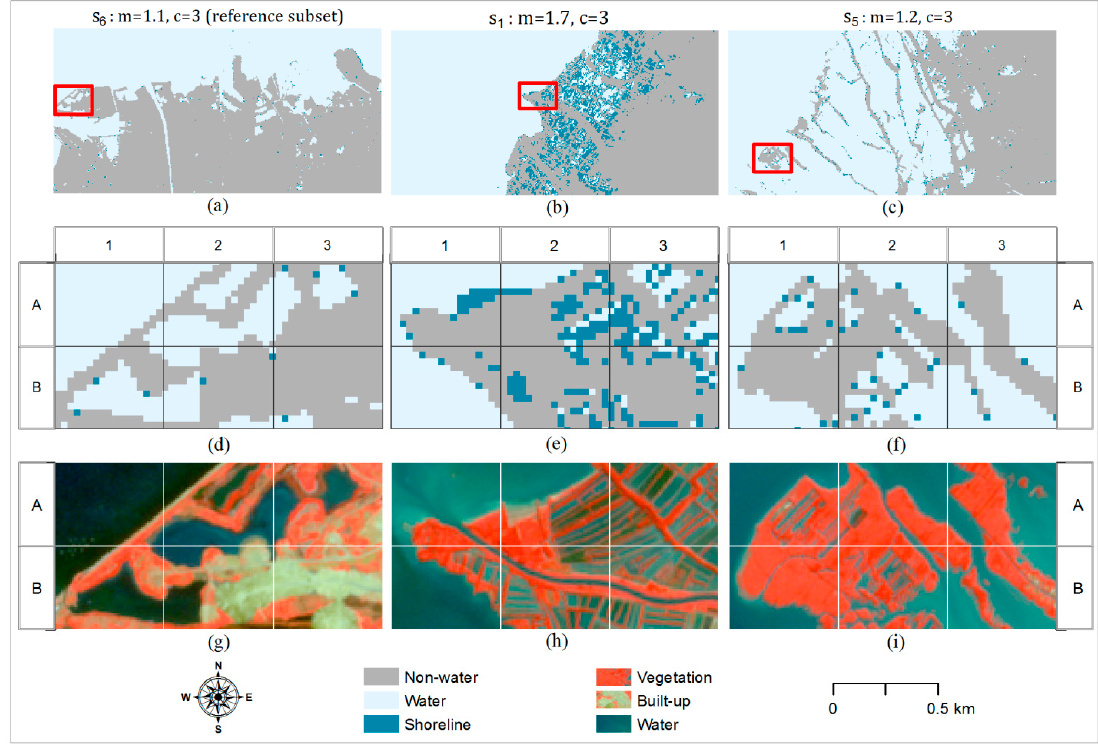
Figure 12. Subset s 6 ( a ) is the reference subset to estimate the FCM parameter for subsets s 1 and s 5 ( b , c ). We zoom into the red rectangle sites to see a more detailed representation of the area ( d – f ). The 2017 Sentinel-2 images show the different types of land use/cover ( g – i ). The applied method clearly failed to identify the water area in subset s 1 ( e , h ) for e.g., grid cells A2, A3, and B2. It also failed to identify the shoreline margin in subset s 5 ( f , i ) near the vegetation areas for e.g., grid cells A1 and B1.